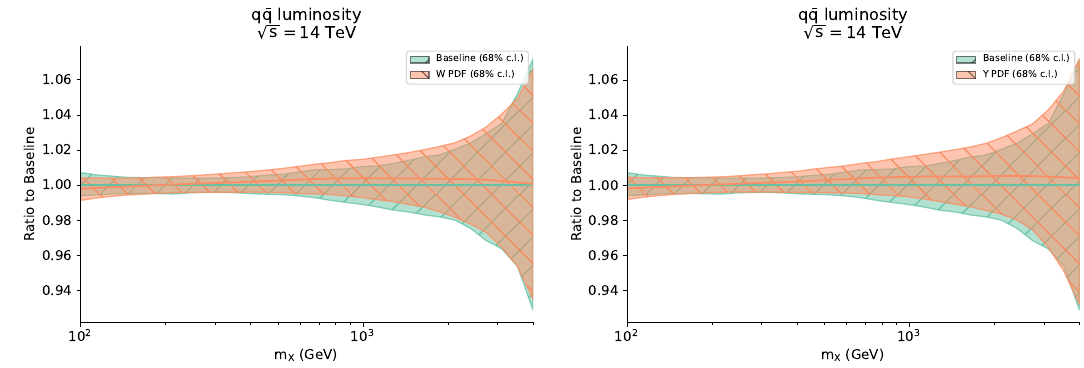
Figure 6 . The one dimensional luminosity in the q ¯ q channel for a PDF fitted in the presence of a non-zero W operator (left panel) or of a non-zero Y operator (right panel) shown in orange, normalized to the SM baseline PDF shown in